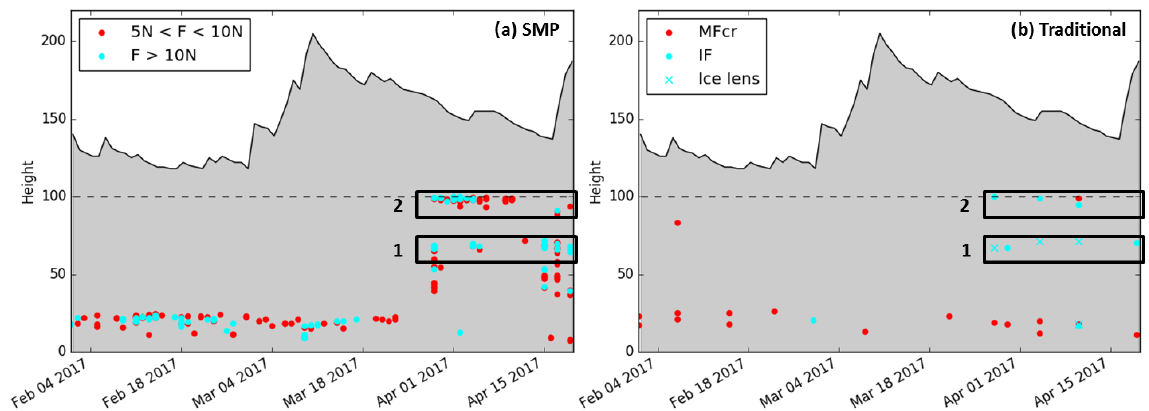
Figure 7. (a) Height of SMP penetration resistances between 5 and 10N (red) and higher than 10N (cyan) below 1m from 1 February to 19 April at WFJ. (b) Visual observations of melt-freeze crusts (MFcr), ice layers (IFil) and ice lenses at the same period and location. Daily manual measurements of snow depth in solid black lines. Rectangles highlight layers 1 and